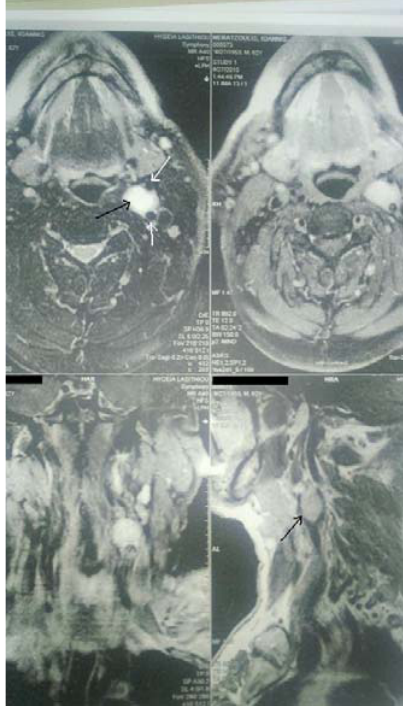
Table 2: Management of patients included in the study. Figure 3: Magnetic resonance image showing a type II carotid body tumor (black arrows) that partially surrounds and compresses the carotid vessels (white